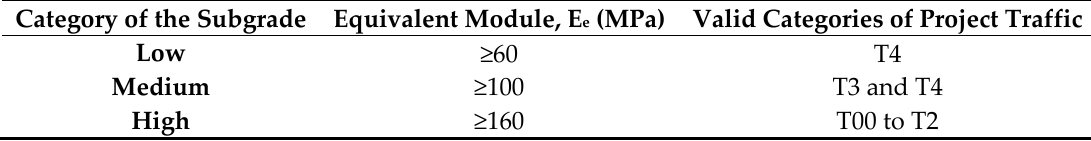
Table 3. Categories of the